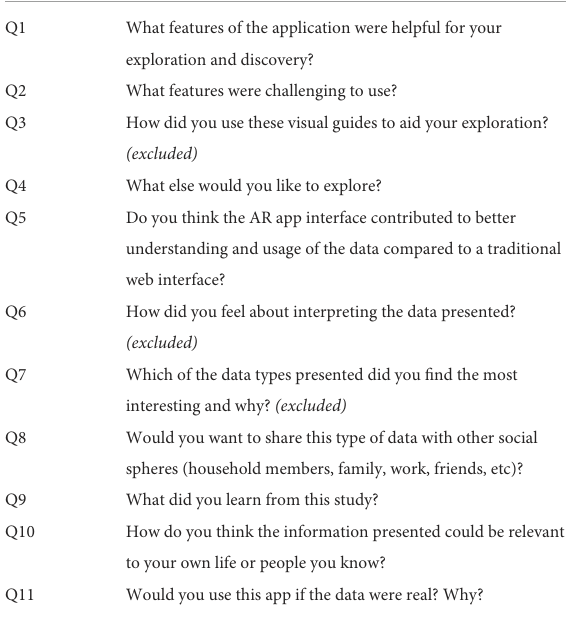
TABLE 2 Study 2 interview